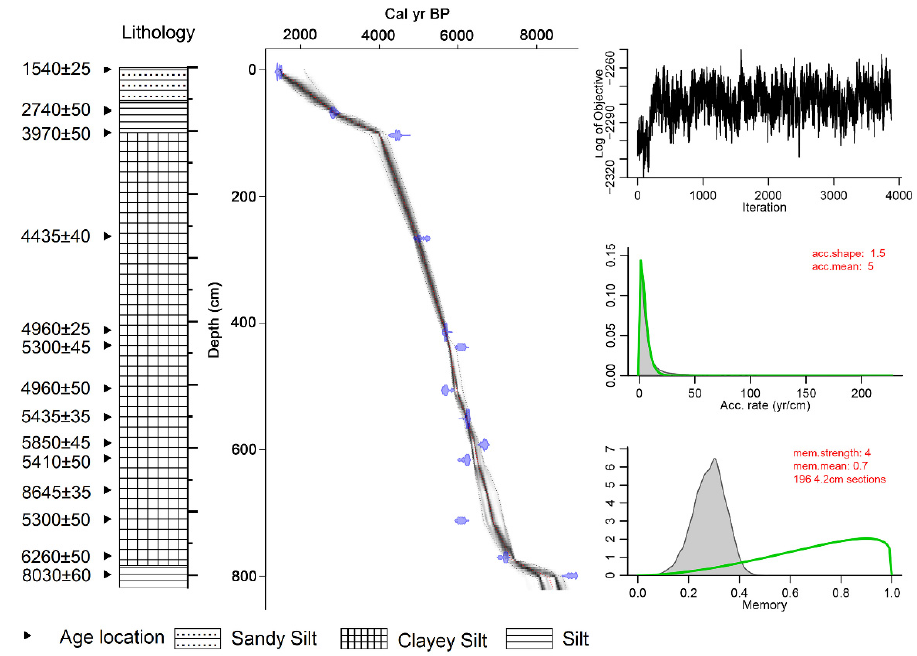
Figure 2. The Bayesian depth–age model of Huangqihai Lake with lithologic change. Based on the depth–age model, sediment accumulation rate (SAR; mm yr − 1 ) for the sediment column was calculated (Equation (1)): SAR = Depth range/Age range.